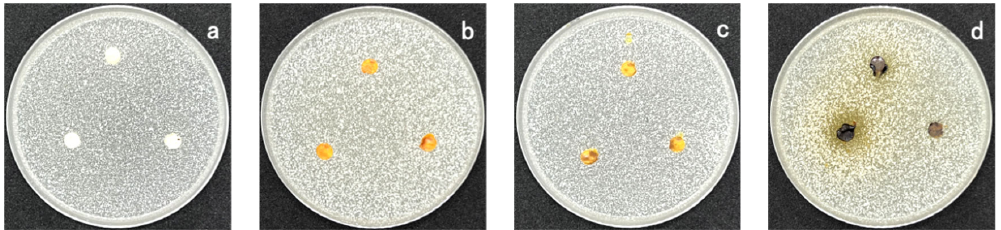
Figure 3. Inhibitory effects of steam distillation extract ( a ), n-hexane extract ( b ), petroleum ether Figure 3. Inhibitory e ff ects of steam distillation extract ( a ), n-hexane extract ( b ), petroleum ether Figure 3. Inhibitory e ff ects of steam distillation extract ( a ), n-hexane extract ( b ), petroleum ether Figure 3. Inhibitory e ff ects of steam distillation extract ( a ), n-hexane extract ( b ), petroleum ether extract ( c ), and ethanol extract ( d ) on Candida albicans . extract ( c ), and ethanol extract ( d ) on Candida albicans . extract ( c ), and ethanol extract ( d ) on Candida albicans . extract ( c ), and ethanol extract ( d ) on Candida albicans . Table 3. Diameter of antimicrobial zone of different extracts against E. coli , S. aureus , and C. albicans Table 3. Diameter of antimicrobial zone of di ff erent extracts against E. coli , S. aureus , and C. albicans . Table 3. Diameter of antimicrobial zone of di ff erent extracts against E. coli , S. aureus , and C. albicans . Table 3. Diameter of antimicrobial zone of di ff erent extracts against E. coli , S. aureus , and C. albicans .